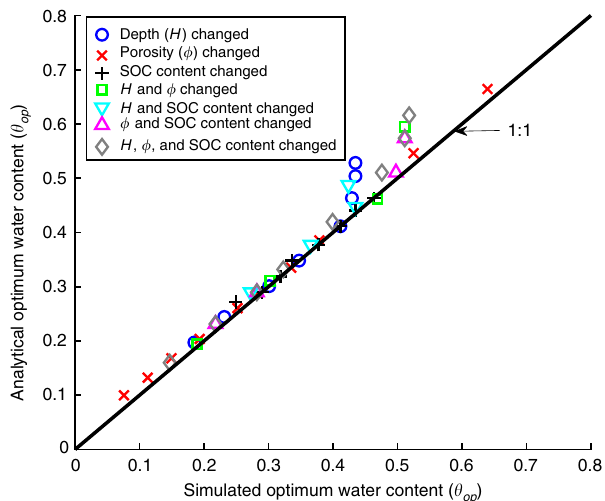
Fig. 4 Evaluation of the analytical optimum water content θ op . Each symbol represents a comparison between the simulated and the analytical θ op for a simulated homogenous soil core. The simulated θ op was derived from the simulated heterotrophic respiration (HR) – moisture relationship obtained by the microscale model (see Methods section); the analytical θ op was calculated using Eq. (11) in Methods section. The different symbols represent comparisons for different simulated soil cores with a wide range of depths H , 2.5 ≤ H ≤ 100 cm, porosity values ϕ , 0.2 ≤ ϕ ≤ 0.8, and SOC contents C SOC , 0.005 ≤ C SOC ≤ 0.2 g g − 1 . The base values were H = 20 cm, ϕ = 0.58, and C = 0.02 g g − 1 in the SOC